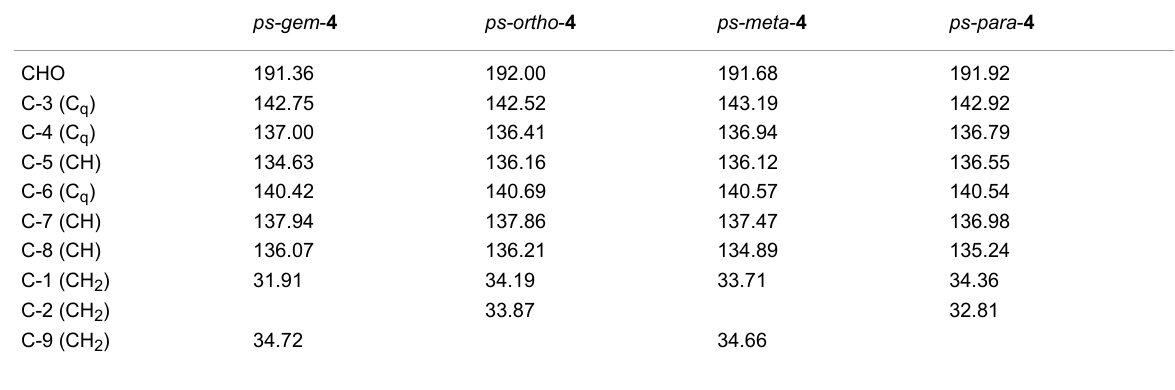
Table 2: 13 C NMR data of the isomeric dialdehydes (CDCl 3 , δ = 77.01 ppm). ps-gem - 4 ps-ortho - 4 ps-meta -